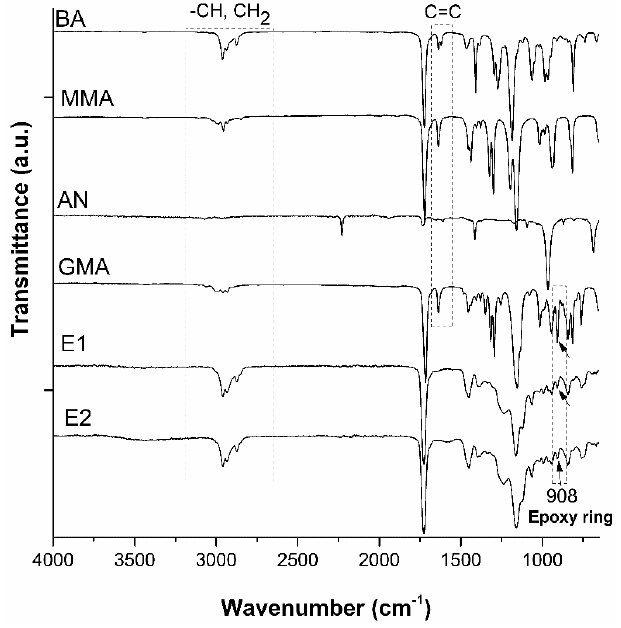
8 of 15 Figure 2. TEM images of the latex particles: ( a ) Latex E1, ( b ) Latex E2.